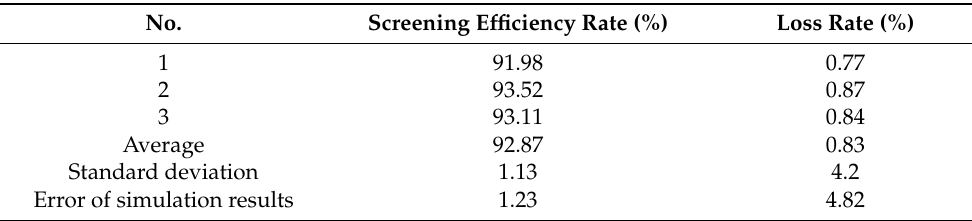
Table 6. Results of field